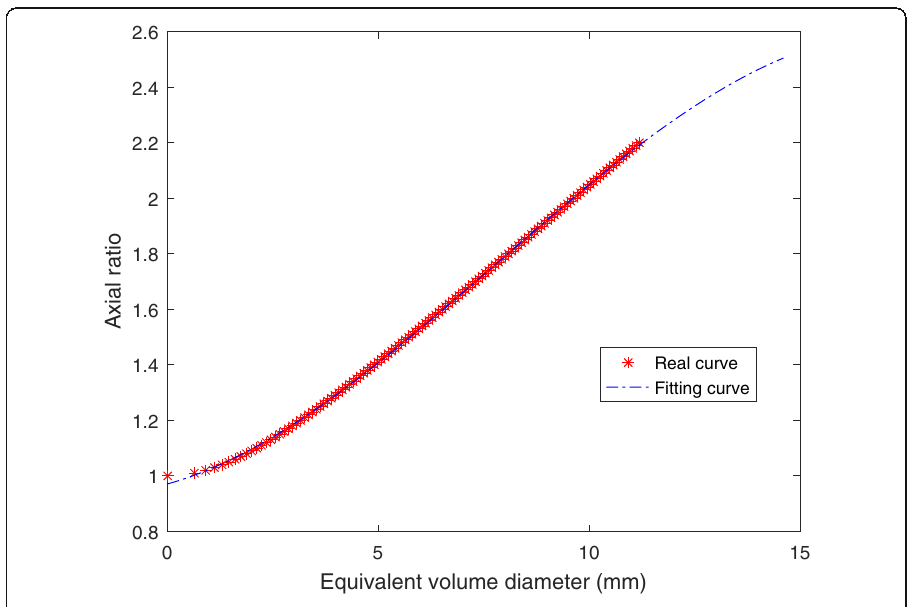
Fig. 2 Fitting effect of the least square